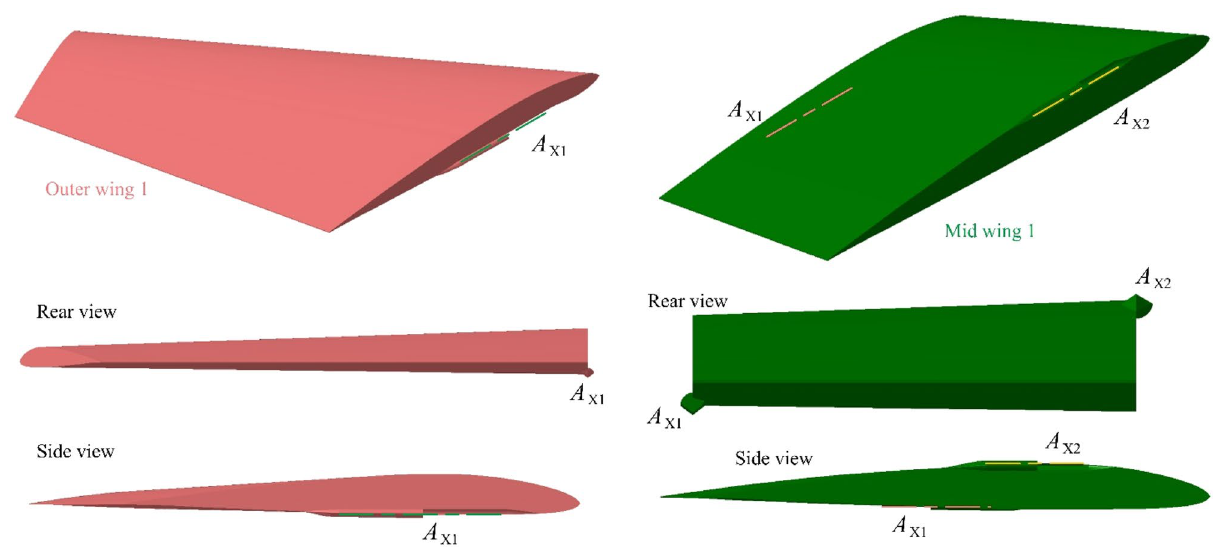
Figure 4. Detail display of outer wing 1 and mid wing